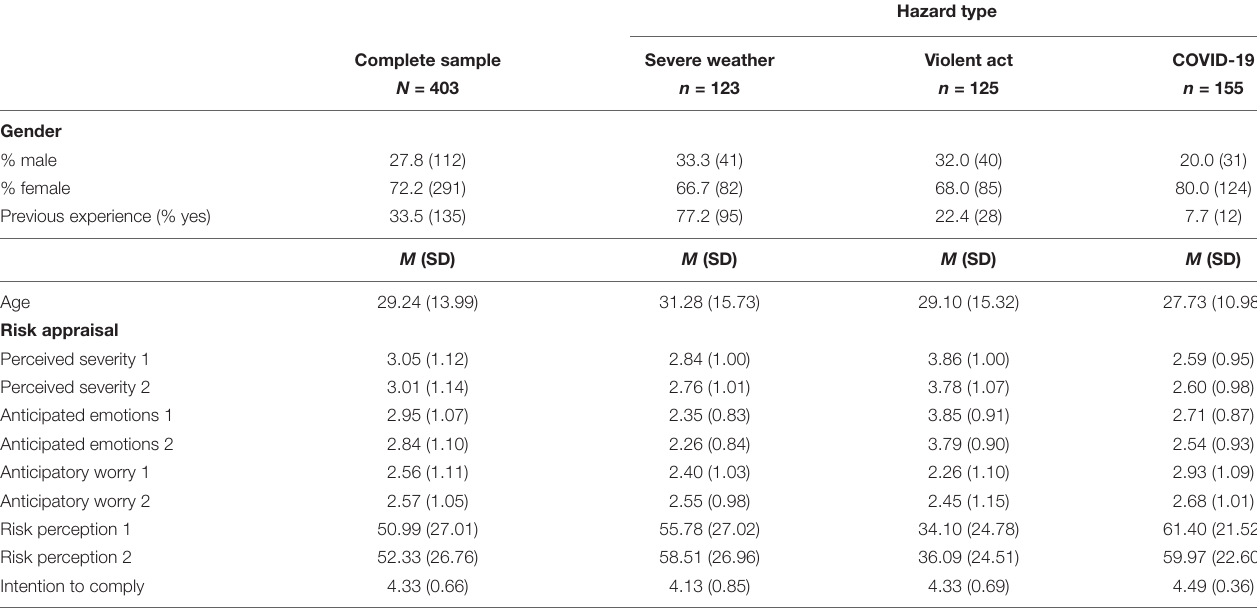
TABLE 1 | Descriptive statistics of age, gender, previous hazard experience, the components of risk appraisal before (1) and after (2) the receipt of a warning message, and the intention to comply with a warning message, displayed for the complete sample and separated by hazard type.